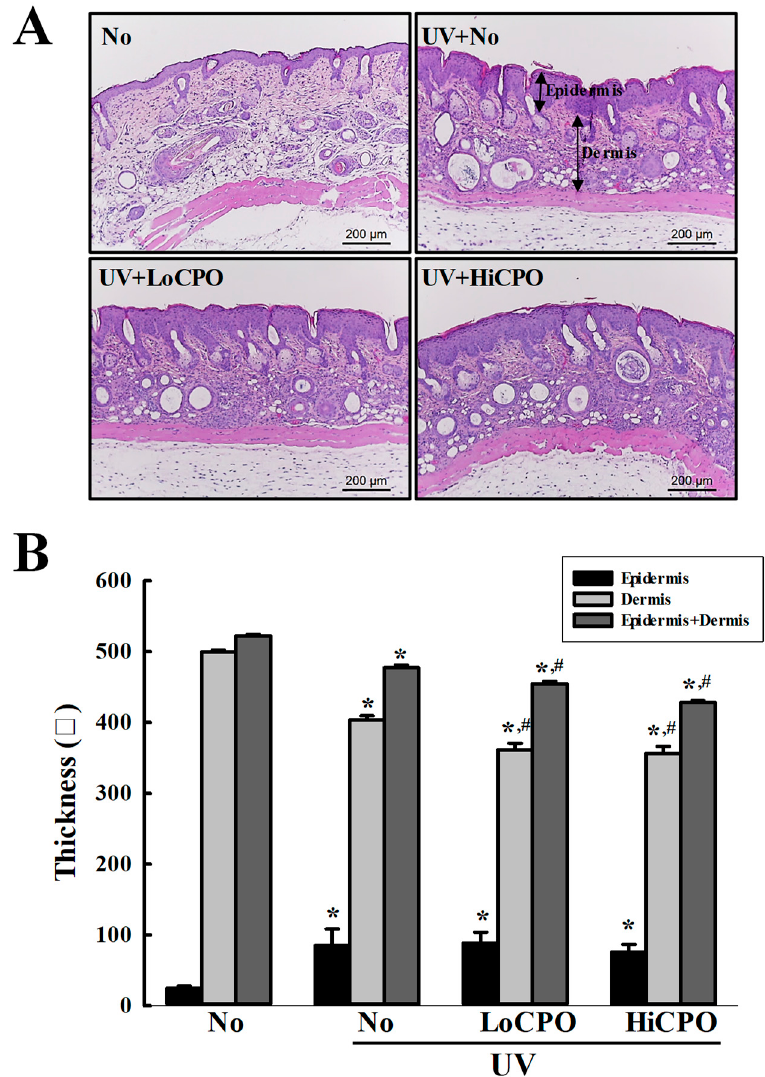
Figure 8. Histopathological structures of skins. ( A ) Image of H&E stained skin tissue. The dorsal skin tissues of hairless mice were fixed in 4% formaldehyde and stained with H&E solution. Histological changes were observed at 200 × magnification under a microscope. ( B ) Epidermal and dermal thickness. H&E stained slides were prepared for three to five mice per group and epidermal thicknesses were assayed in duplicate for each mouse. Data are reported as the means ± SD. * p < 0.05 compared to the No group. # p < 0.05 compared to the UV + No group. Abbreviations: LoCPO, low amount CPO; HiCPO, high amount